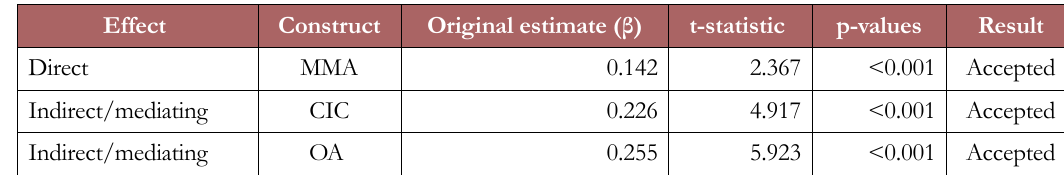
Table 6. Hypothesis test results of the operational performance